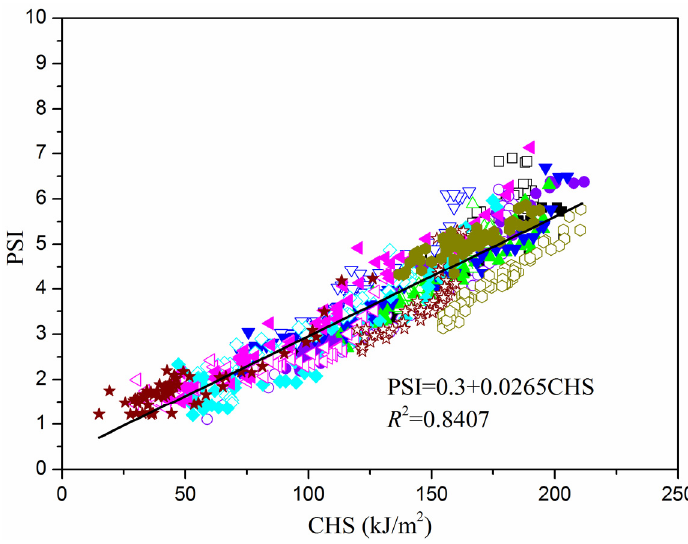
Figure 7. Relationship between PSI and CHS ( n = 960).